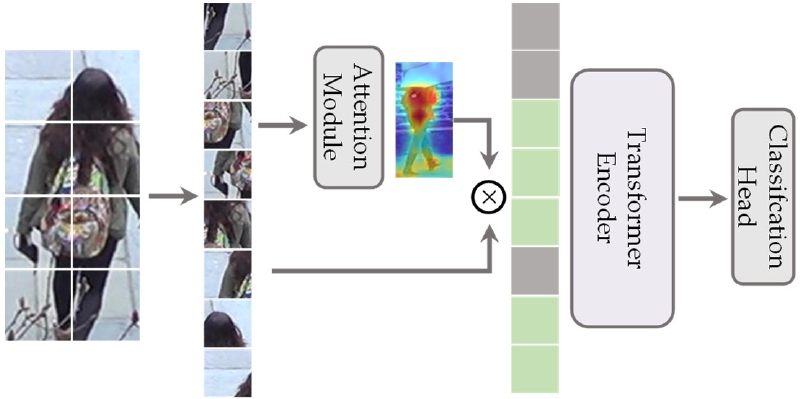
Figure 2. The process diagram of the attention mechanism to enhance Transformer architecture.